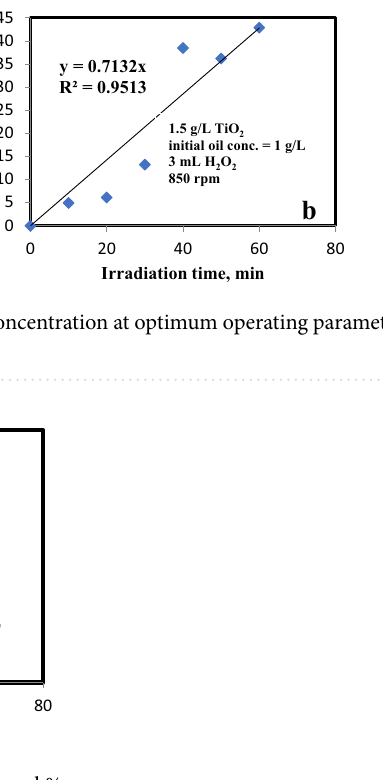
Figure 11. Addition of H 2 O 2 effect on an oil removal